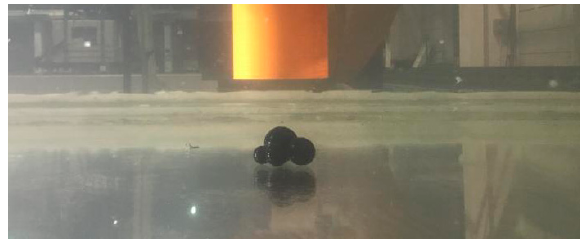
Figure 15. A snapshot of multiple particles without circular motion .